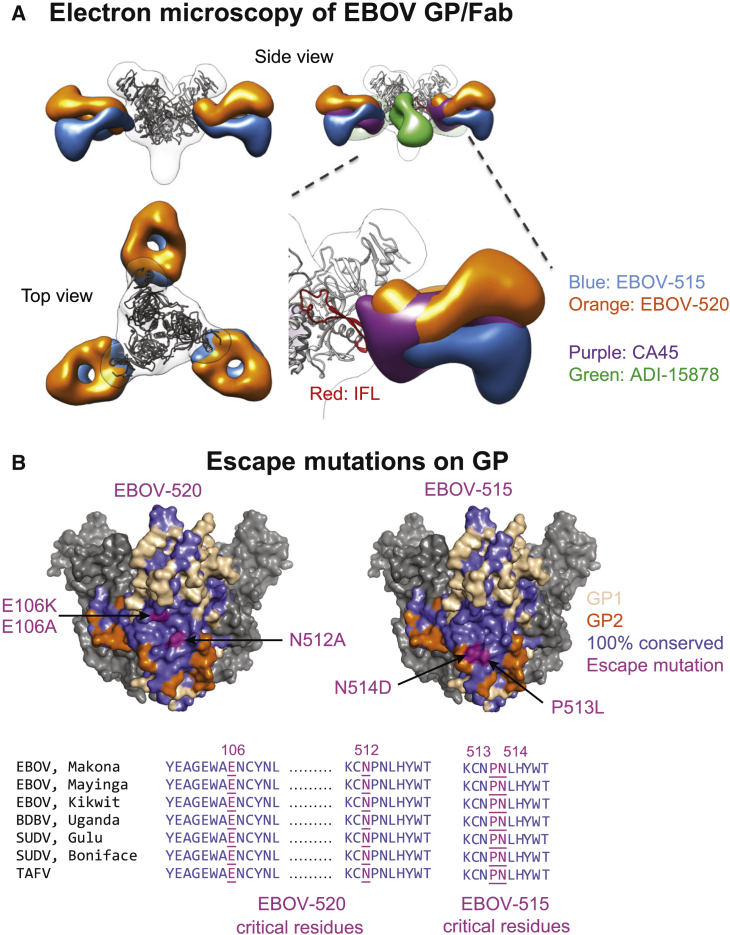
EBOV-515 and -520 Recognize Distinct Vulnerable Epitopes in the Ebolavirus GP Base Region(A) 3D reconstructions of Fab/EBOV GP ΔTM complexes. EM density for Fab of EBOV-515 (blue), or -520 (orange), or previously described CA45 (violet), or ADI-15878 (green) are superimposed to compare the angle of approach for these four GP base-reactive mAbs. A model of the EBOV GP ΔTM trimer was fitted into the EM density.(B) Escape mutations (magenta) for EBOV-515 or -520 identified by alanine-scanning mutagenesis of cell surface-displayed EBOV GP library or by sequence analysis of escape mutant viruses (top). Conservation of ebolavirus GP sequences within putative mAb epitopes (bottom).See also Figure S5.